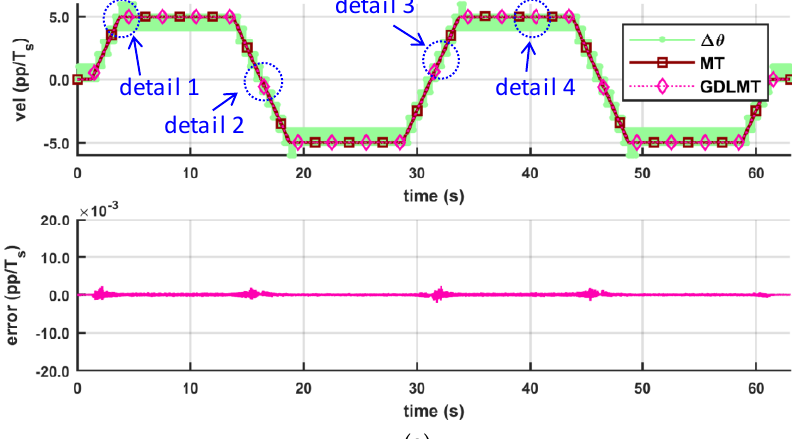
Figure 10. Comparison of the MT method and the GDLMT method at high speed: ( a ) full time interval; ( b ) detail 1 with velocity overshoot (peak velocity); ( c ) detail 2 with velocity zero crossing; ( d ) detail 3 with ramp velocity (constant acceleration), and ( e ) detail 4 with constant velocity.